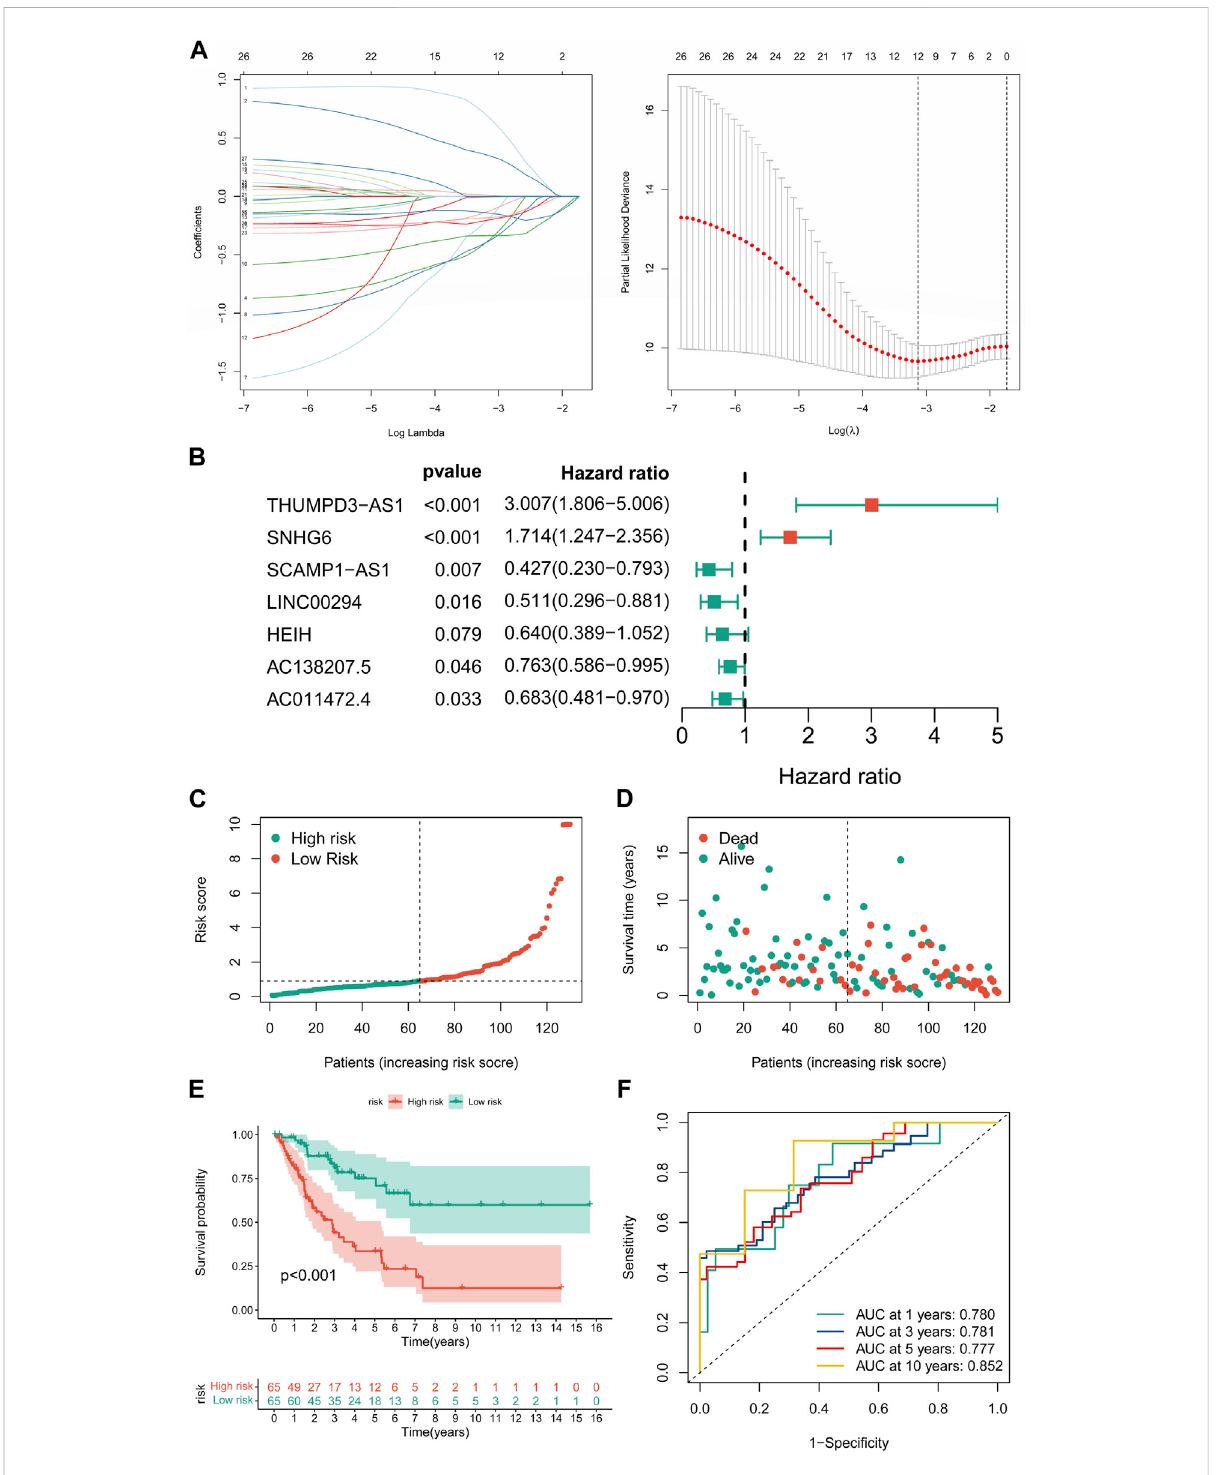
FIGURE 3 Construction of the novel CRLncSig. (A) The LASSO COX regression analysis. (B) The forest plot of the prognostic ability of the 7 CRLs included inCRLncSig. (C,D) Thedistributionofriskscoreandpatientsurvivalstatus. (E) TheK-MsurvivalcurvesofthenovelCRLncSiginthetrainingcohort. (F) Evaluate the prognostic performance of the risk score using time-dependent ROC in the training